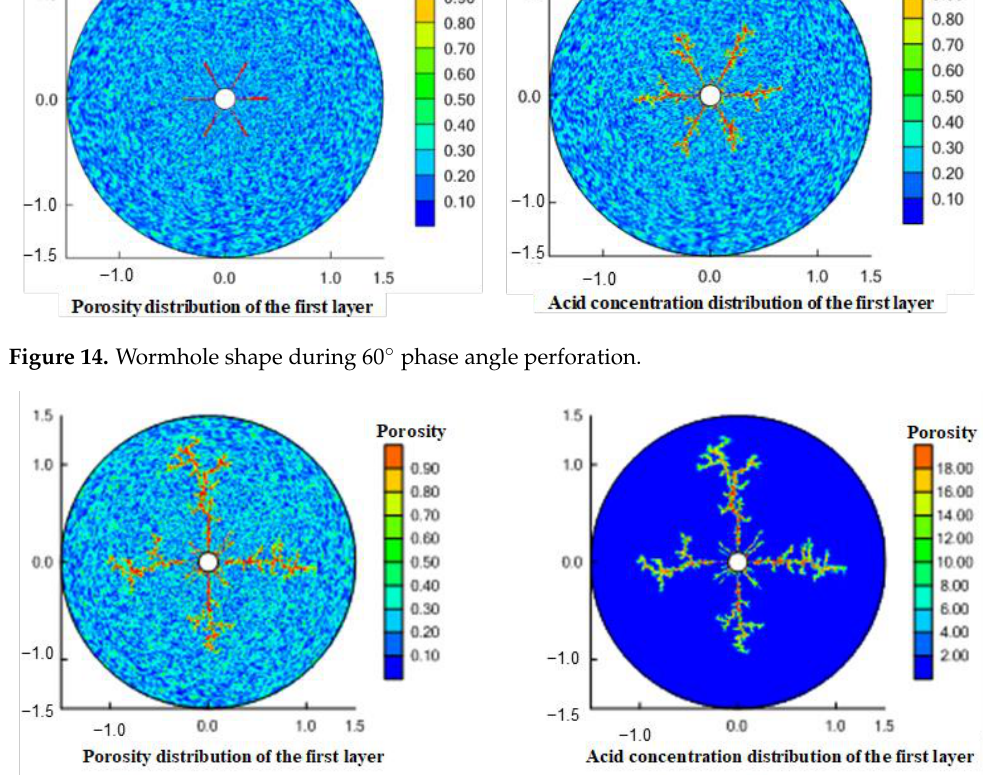
Figure 15. Wormhole shape during 90° phase angle